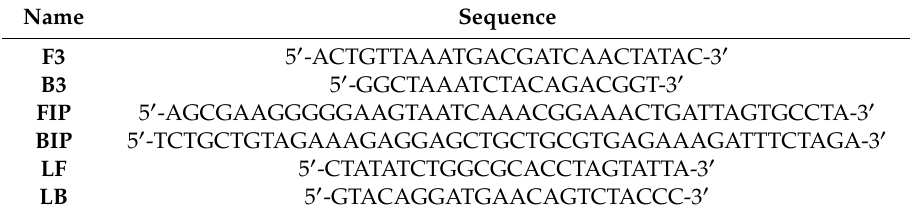
Table 1. LAMP primer sequences for Loligo vulgaris authentication and its discrimination from Loligo reynaudii and Loligo forbesii .